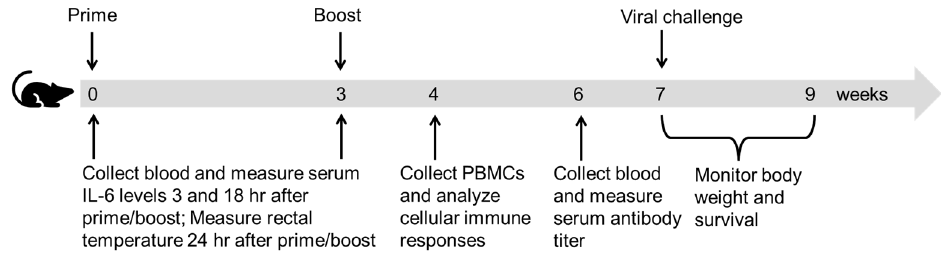
Figure 1. Schematic illustration of experimental design.